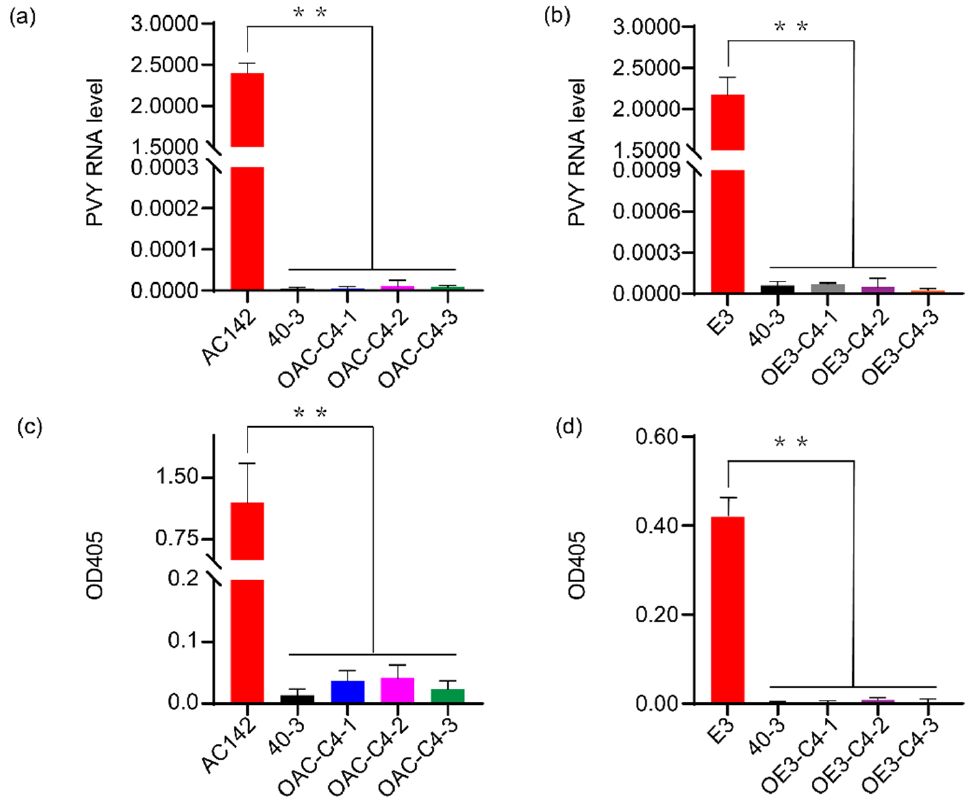
Figure 4. Phenotyping of PVY O resistance in transgenic lines derived from AC142 and E3. ( a ) PVY RNA levels in the non-inoculated leaves of AC142 transgenic plants harboring C4 two weeks after PVY O -FL inoculation. 40-3 indicates S. chacoense accession 40-3, the resistant parent; ( b ) ELISA titers of PVY O -FL in transgenic plants derived from AC142 harboring C4 four weeks after inoculation. An ELISA (ODA405) value <0.1 indicates that the plants were resistant. An ELISA (ODA405) value >0.1 indicates that the plants were susceptible. Data in ( a , c ) are presented as mean values ± SE. ** indicates a statistically significant difference ( p < 0.01) compared to AC142, calculated using a Student’s t -test. Data in ( b , d ) are presented as mean values ± SE. ** indicates a statistically significant difference ( p < 0.01) compared to E3 calculated using a Student’s t -test.